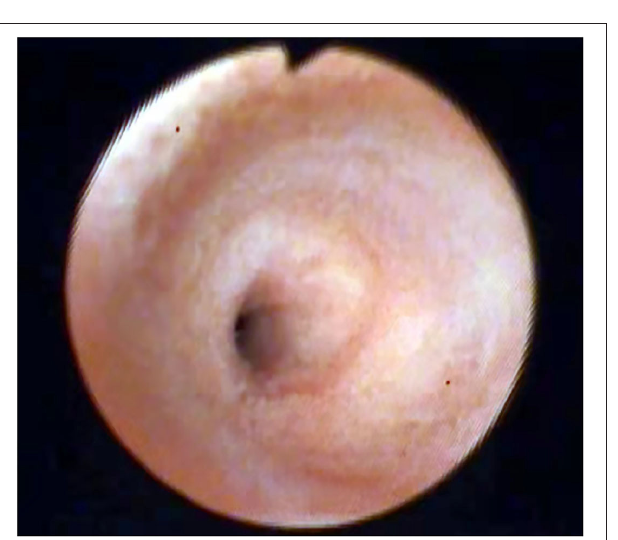
FIGURE 4 | Observe the contraction of the duodenal sphincter.